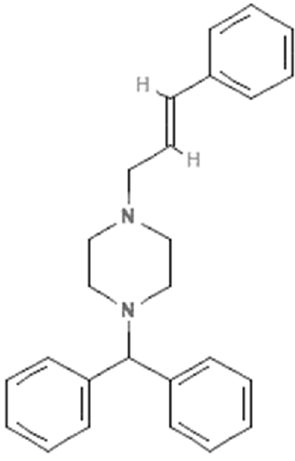
Figure 1. Molecular structure of cinnarizine (CIN).